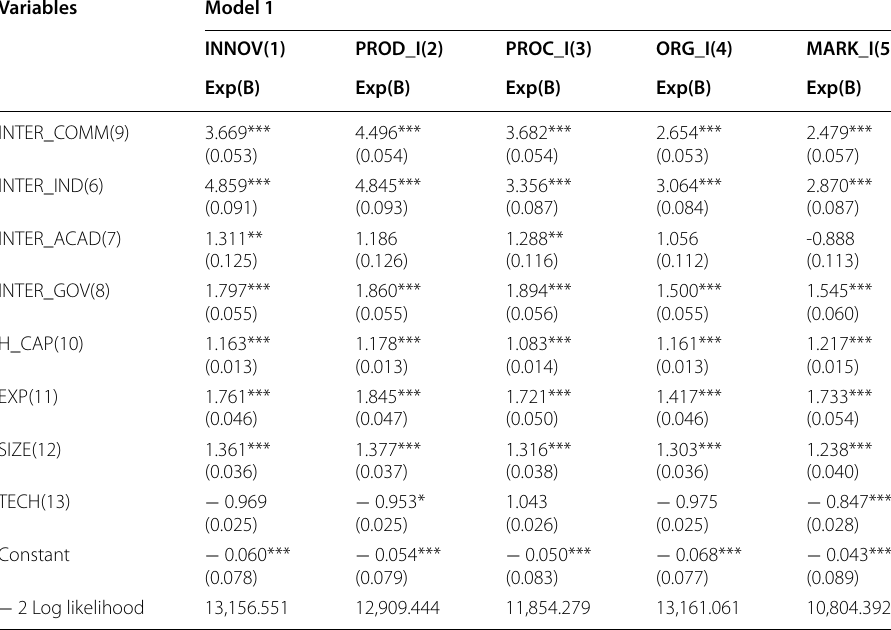
Table 10 Logit models for the different types of